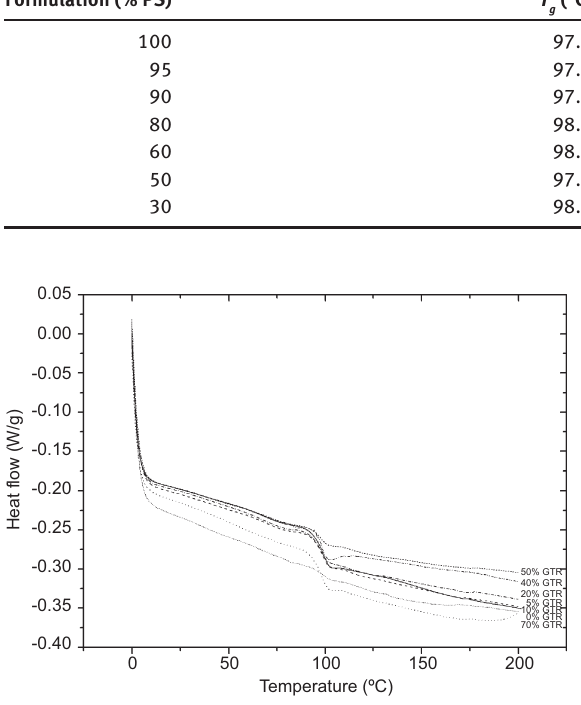
Figure 2 Glass transition of mixtures of PS/GTR for particle sizes < 200 μ